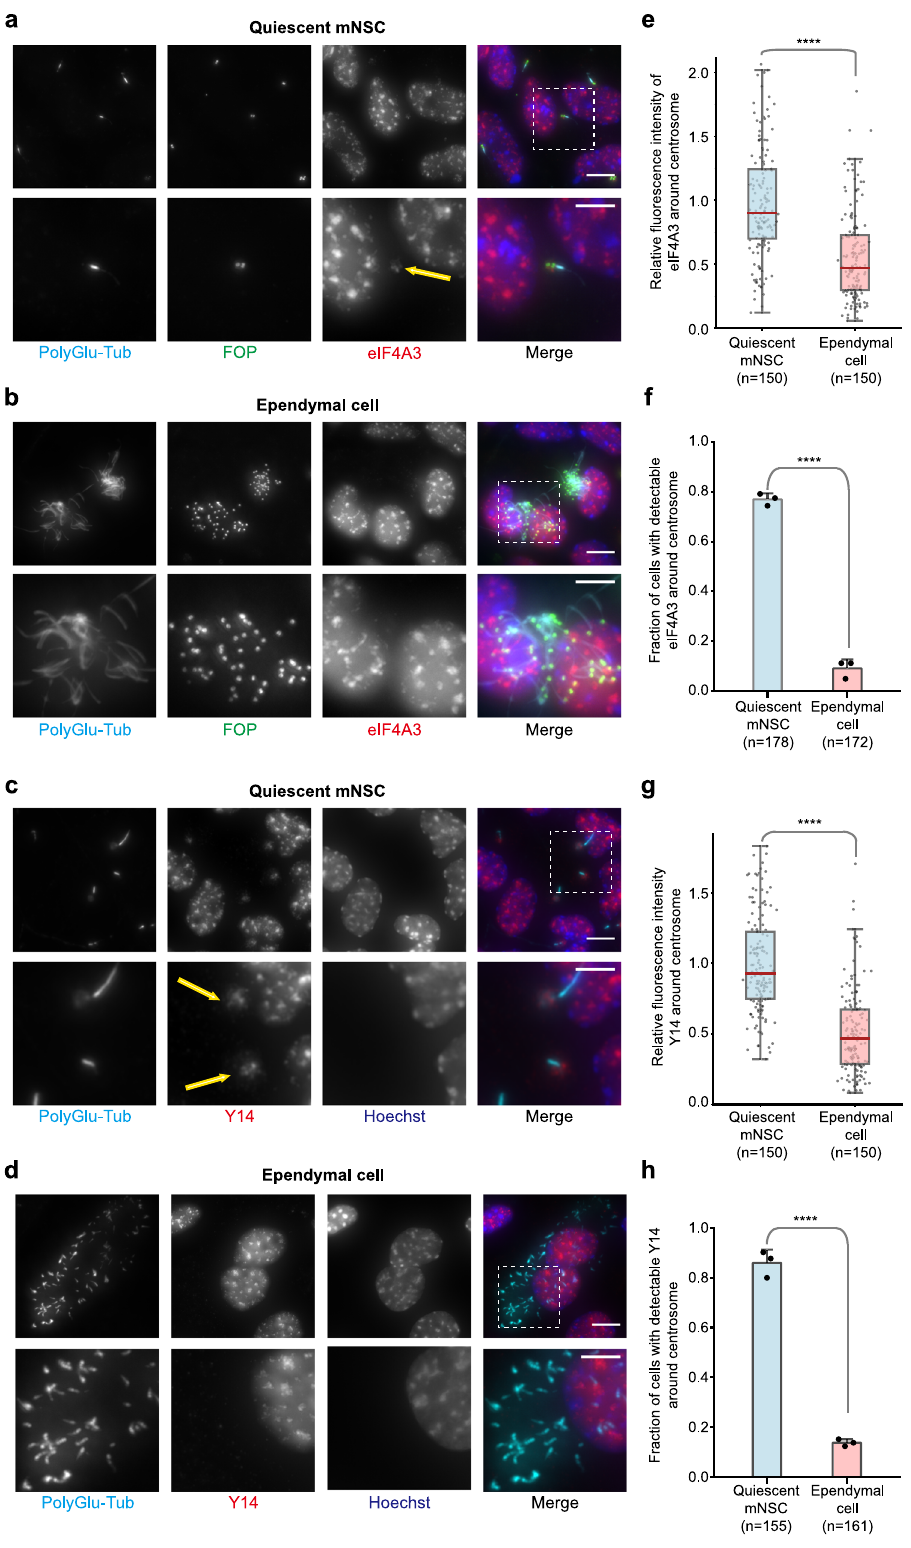
EJC core components accumulate around centrosomes in cili- ated quiescent RPE1 cells . To test the generality of this obser- vation, we investigated the localization of EJC core proteins in the telomerase-immortalized RPE1 cell line hTERT-RPE1, a